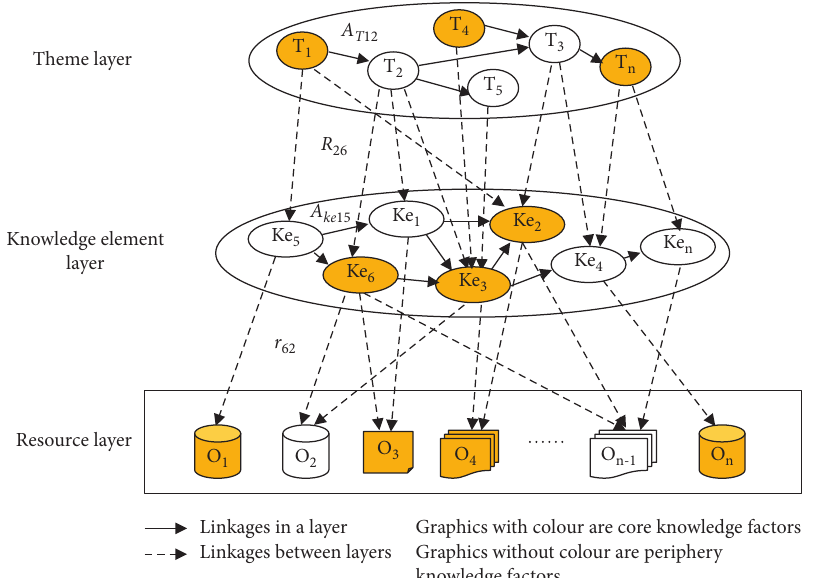
Figure 3: Knowledge map of forerunners shared in R&D